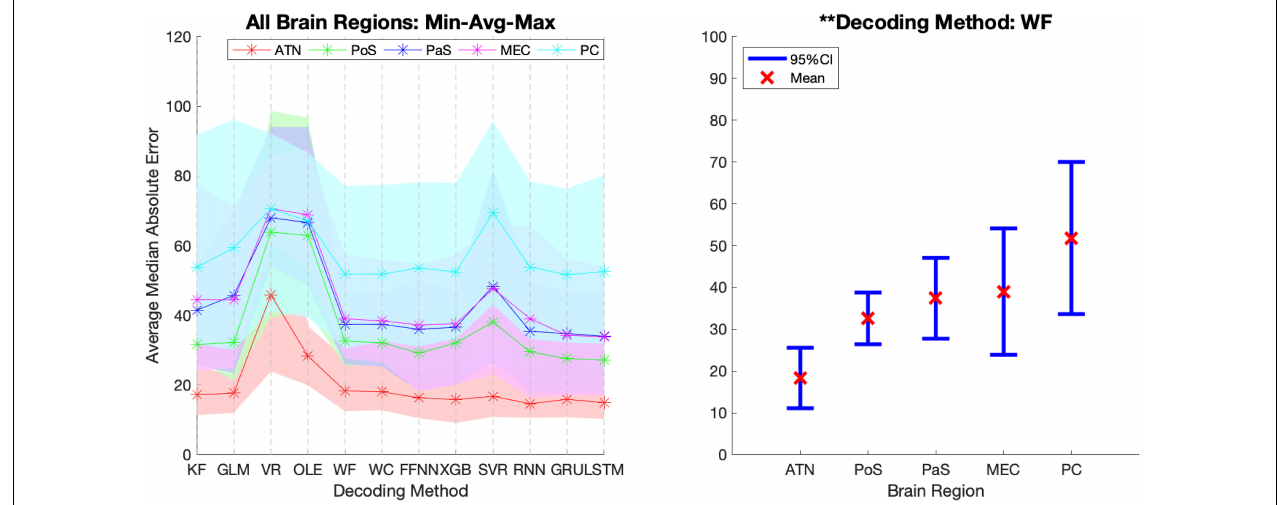
FIGURE 9 | Decoding accuracy varies across brain regions. The average Median Absolute Error (MAE) for each area and each decoding method. The shading in the left panel represents the range of the MAE values while the error bars in the right panel represents the 95% Confidence-intervals of the average MAE values for a representative decoding method. 95% Confidence-interval plots for the remaining 11 methods are shown in Supplementary Material S10 . KF, Kalman Filter; GLM, Generalized Linear Model; VR, Vector Reconstruction; OLE, Optimal Linear Estimator; WF, Wiener Filter; WC, Wiener Cascade; SVR, Support Vector Regression; XGB, XGBoost; FFNN, Feedforward Neural Network; RNN, Recurrent Neural Network; GRU, Gated Recurrent Unit; LSTM, Long Short-Term Memory; ATN, Anterior Thalamic Nuclei; PoS, Postsubiculum; PaS, Parasubiculum; MEC, Medial Entorhinal Cortex; PC, Parietal Cortex. ∗∗ p <